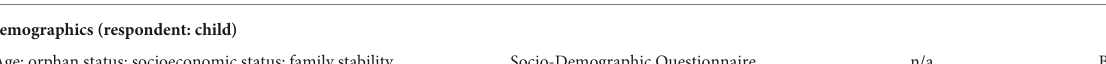
TABLE 2 Variables, instruments, reliability, and assessment time points.